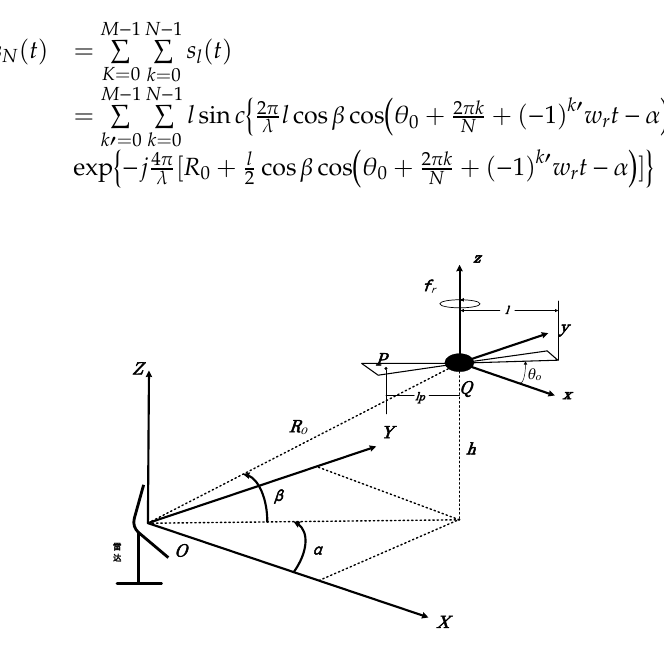
Figure 1. The geometry of the single rotary-wing and the radar.